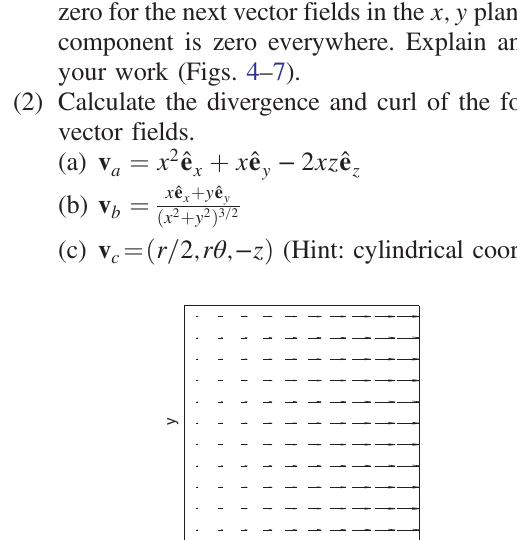
FIG. 7. Pretest field 4.